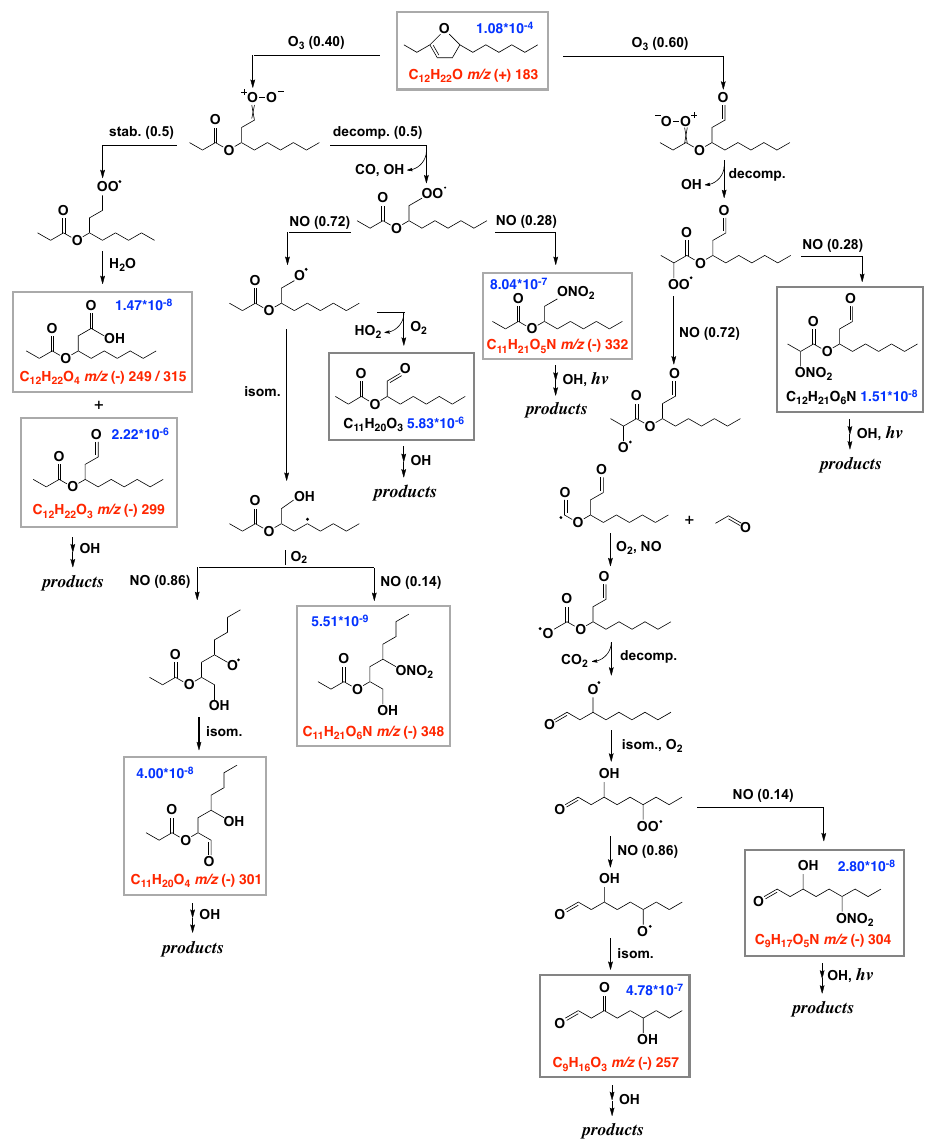
Fig. 2b. Proposed mechanism for the ozonolysis of alkyl-substituted dihydrofuran under high-NO x conditions. The boxes indicate compounds or reaction pathways incorporated in the model simulation. CIMS monitored species have m/z noted in red. Estimated vapor pressure (atm) of each compound is indicated in blue.